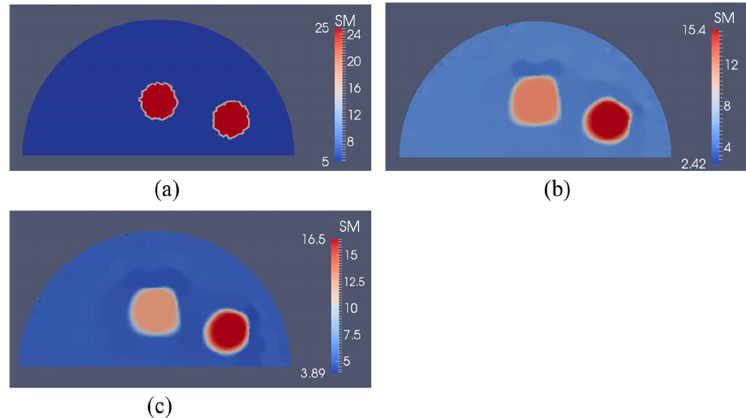
Figure 16. Shear modulus reconstructions with 0.1% noise. ( a ) target shear modulus distribution for comparison; ( b , c ) reconstructed shear modulus distribution using 5 and 10 boundary displacement data sets, respectively (unit in the scale bar: kPa). Note: “SM” stands for shear modulus. Sensors 2017 , 17 , 1075 15 of 20